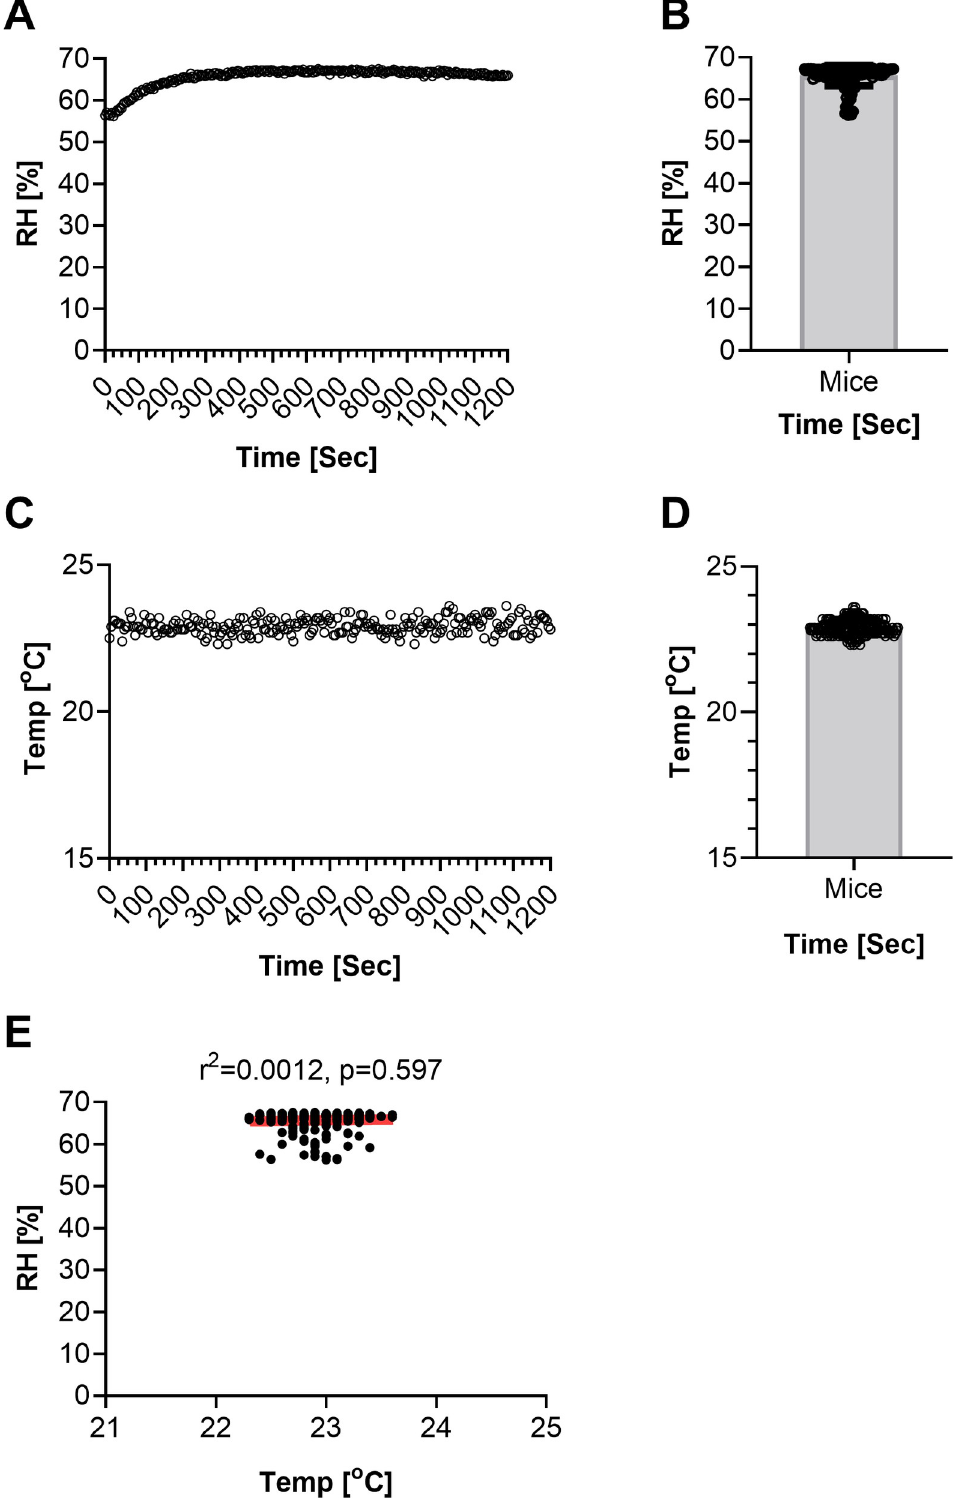
Fig 4. Environmental factors measured in chamber during Mtb-aerosol exposure of mice. Range of environmental factors measured during mouse aerosol procedures using the AeroMP system; range of relative humidity plotted with respect to time (0–1200 sec) (A), mean relative humidity plotted versus time (B), range of relative humidity plotted